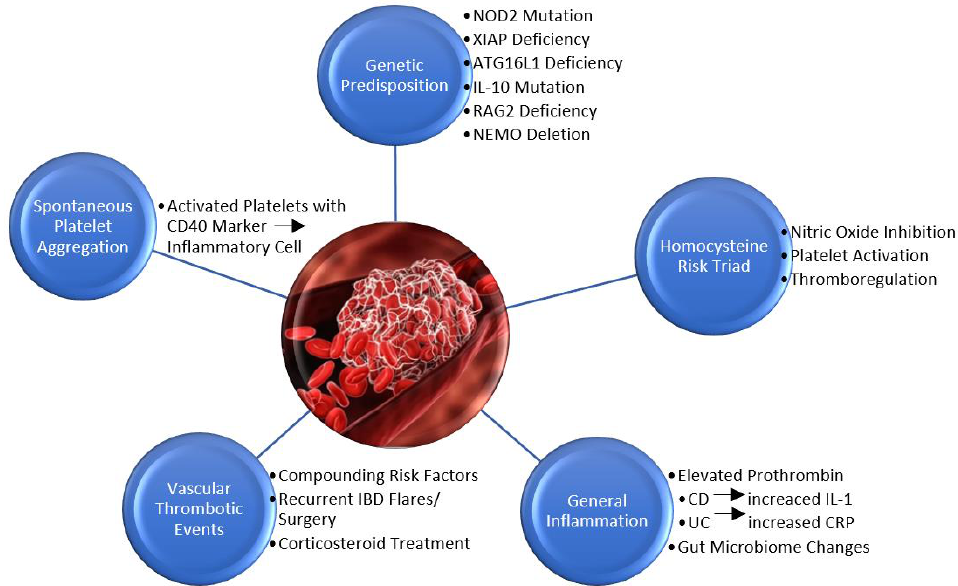
Figure 1. Summary of risk factors contributing to thrombosis in IBD.